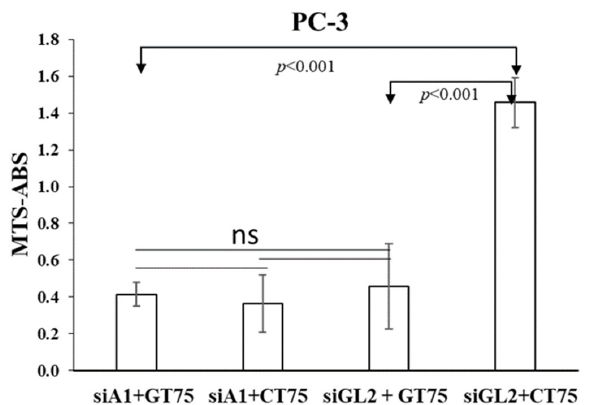
Figure 6. Effects of siRNA and GT75 aptamer co-transfection on PC-3 viability. Evaluation on PC-3 viability of the effects of eEF1A1 targeting by an siRNA (siA1) followed by GT75 administration. Four days after eEF1A1 depletion by siA1 (250 nM), PC-3 cells were transfected by GT75 or the